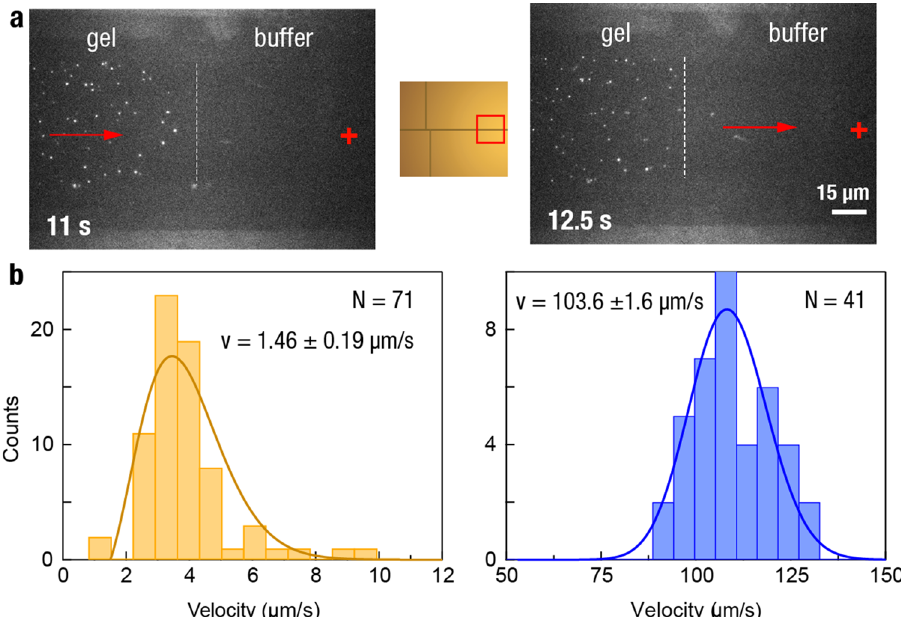
Figure 7. Characterization of single protein velocity distributions before and after exiting the gel. ( a ) Individual gel-embedded Atto647N-labeled BSA proteins are pulled in the direction of a 30 V applied bias until they reach the gel exit (indicated by the white dashed line) and accelerate from a mean of 1.46 ± 0.19 µm/s to 104.5 ± 1.3 µm/s. Inlet shows the position on the chip. ( b ) Histogram of protein velocity before (yellow, N =